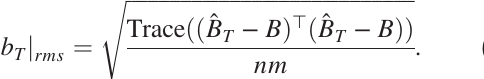
ˆ B (bottom) for 10 5 iterations. The noise level was chosen